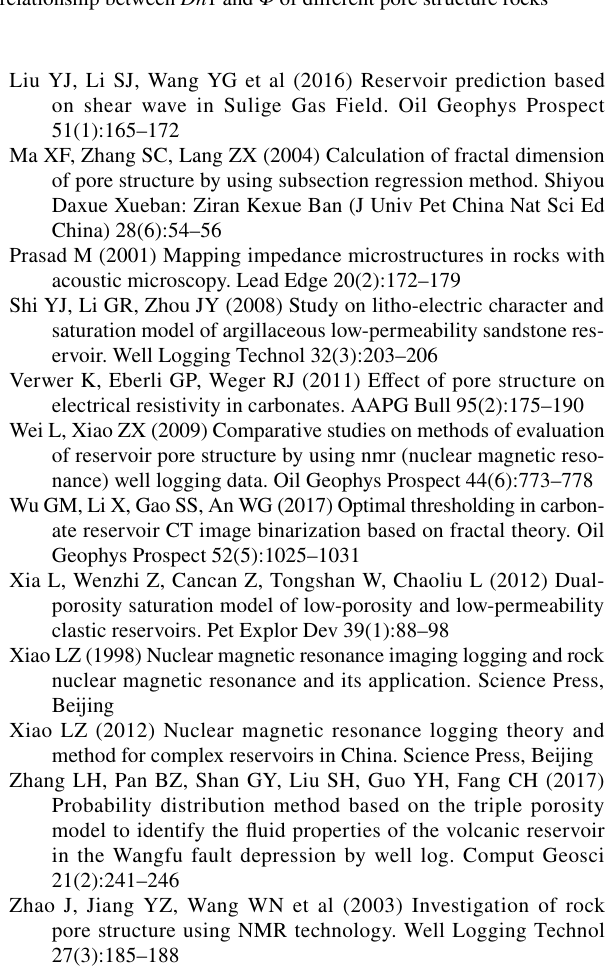
Fig. 18 a Relationship between T Φ of different pore structures; b relationship between Dh 1 and Φ of different pore structure 2gm and